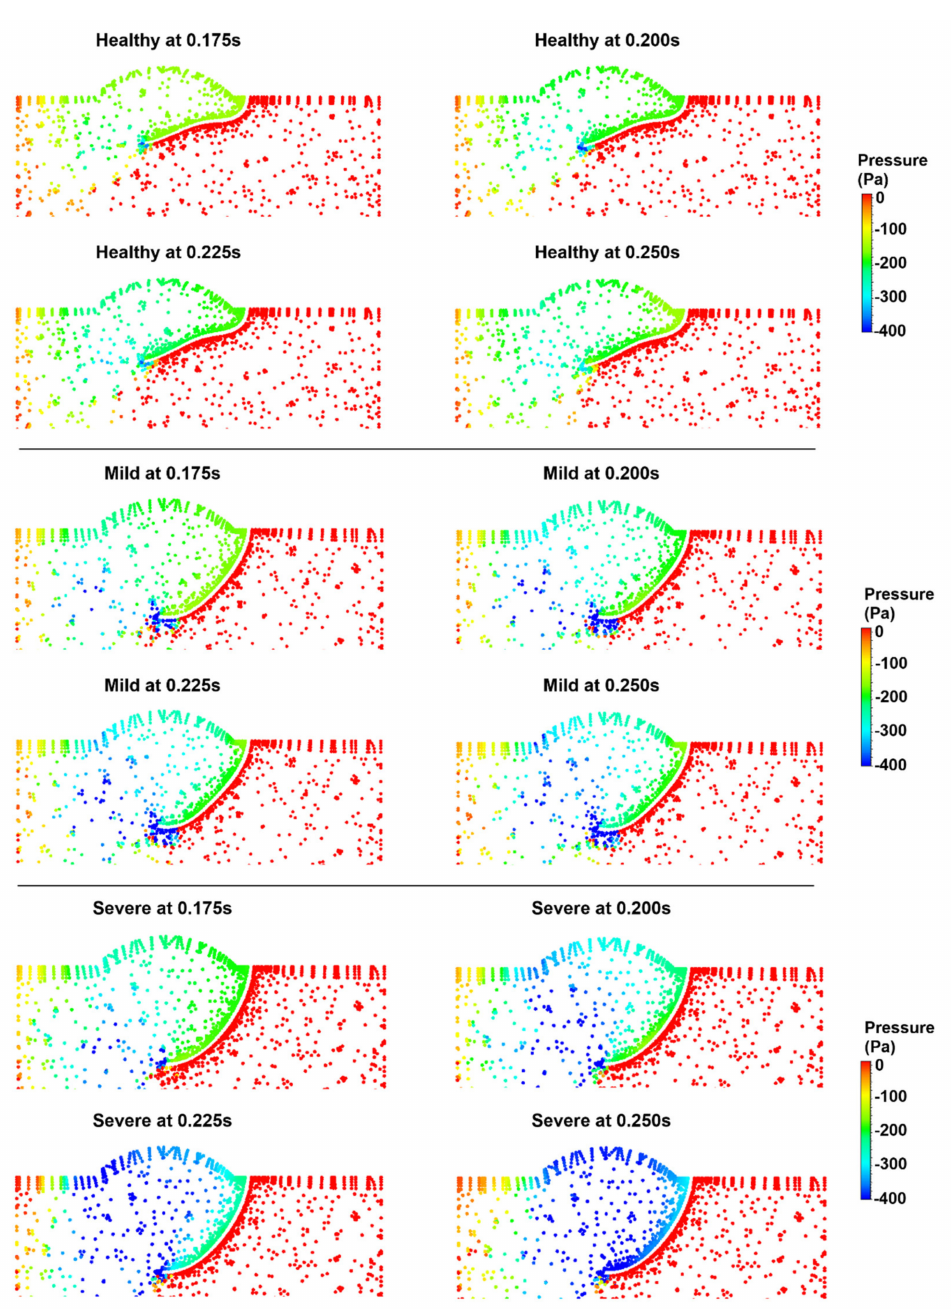
Figure 3. Pressure on the selected fluid particles for healthy, mildly calcified, and severely calcified aortic valves. The results are shown on the top half of the cross-sectional plane given in Figure 1. The flow was from right to left. The values presented are pressures relative to the valve outlet. The pressure was set to zero at the outlet